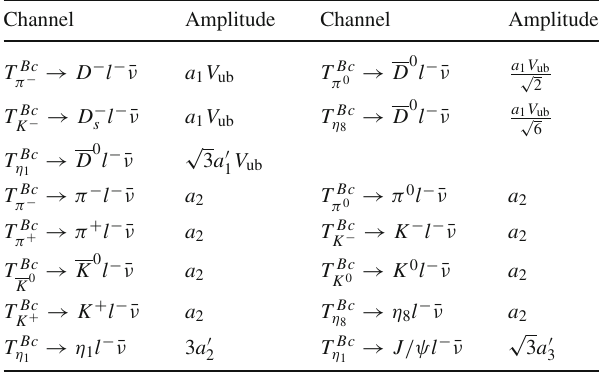
Table 2 Amplitudes for tetraquark T b ¯ c 8 / T b ¯ c 1 decays into a B meson Channel Amplitude Channel